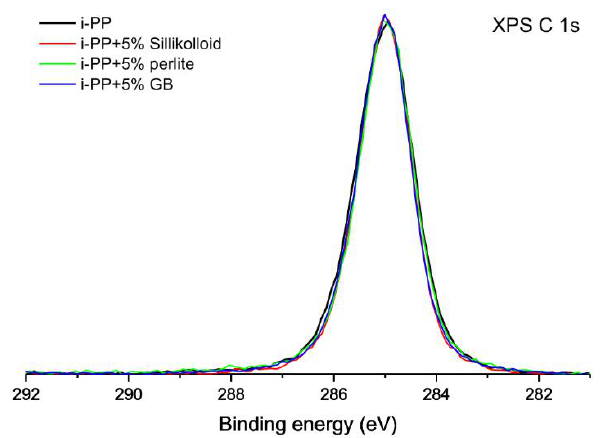
Figure 1. High-resolution X-ray photoelectron spectra of the unoriented isotactic polypropylene ( i -PP) film and its films with 5% of the fillers in the energy range of the C 1s signal.